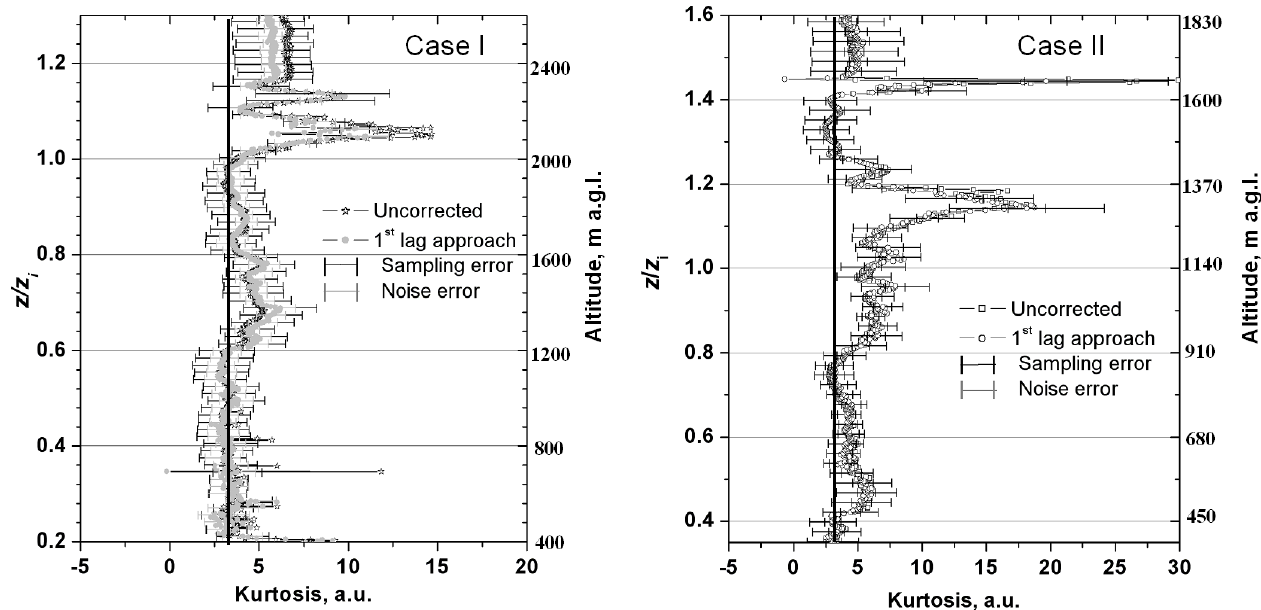
Fig. 14. Same as Fig. 11 but for kurtosis K for Case I (left) and Case II (right). A Gaussian distribution shows K =3 (vertical solid lines on both panels).